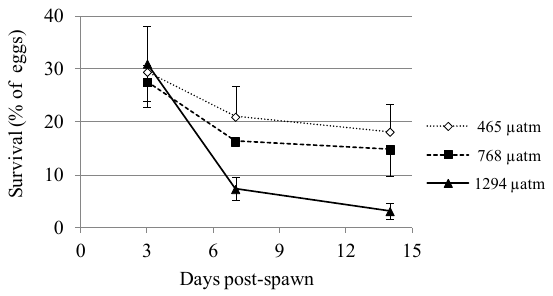
Figure 3. The median percentage of unshelled larvae at day 2 post- spawn, and larvae with protruded velum at day 3 post-spawn, upper and lower quartile ( n = 4) at three p CO 2 levels – 465 (ambient), 768 and 1294µatm.